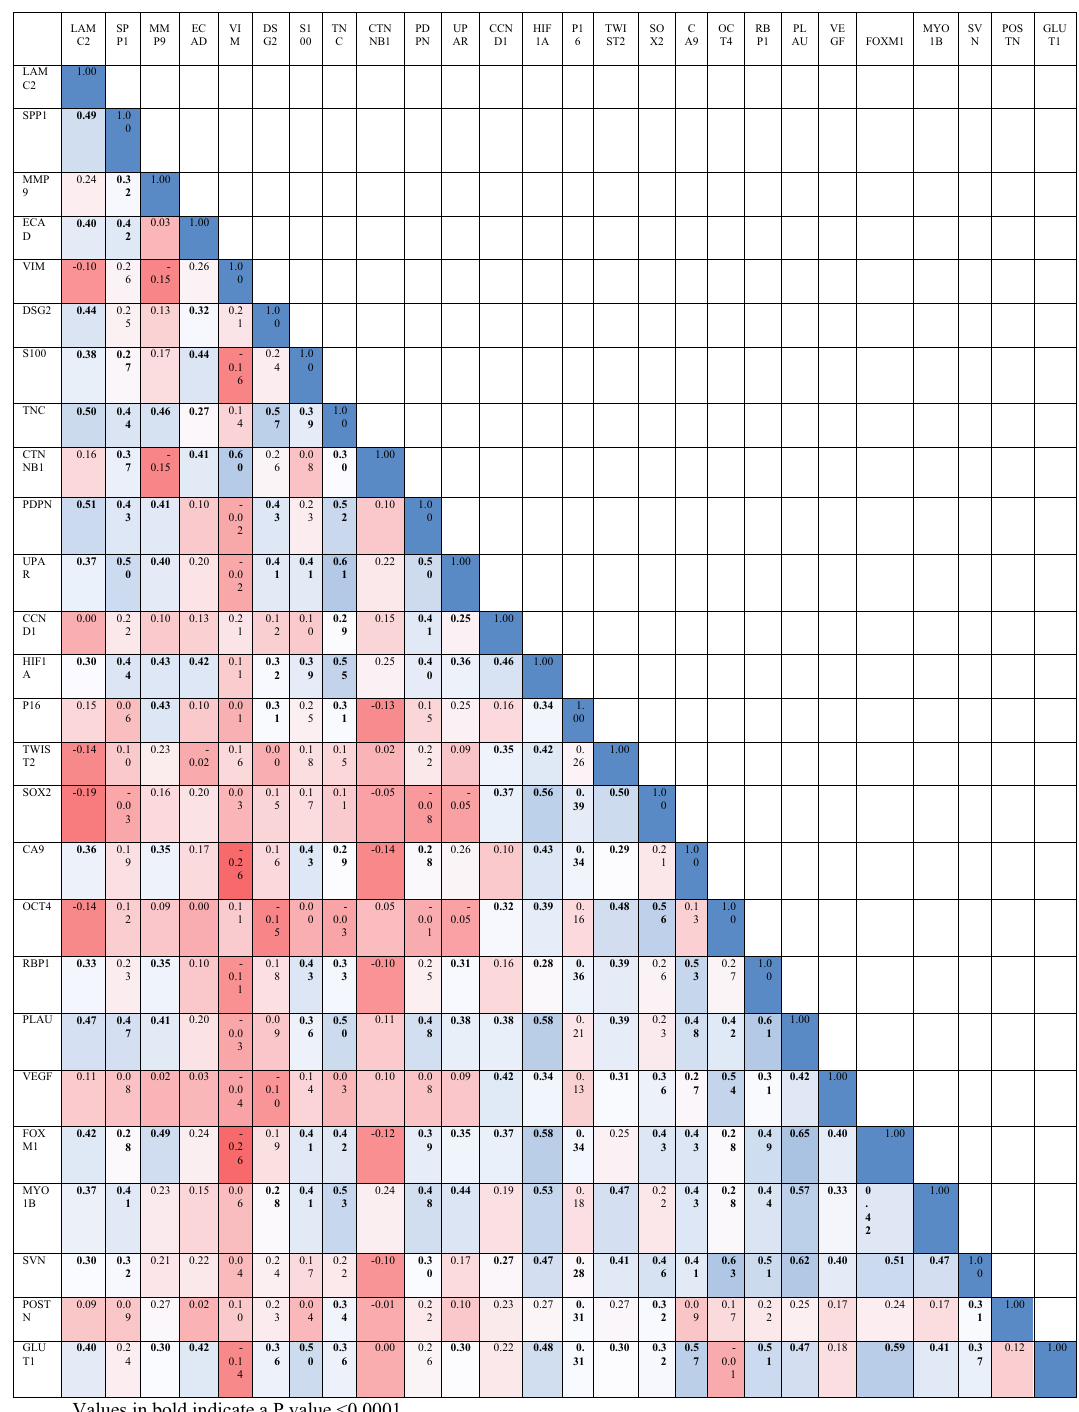
Table 3. Inter-relationship between molecular markers in OTSCC as represented by Pearson’s correlation coefficient. Values in bold indicate a P value <